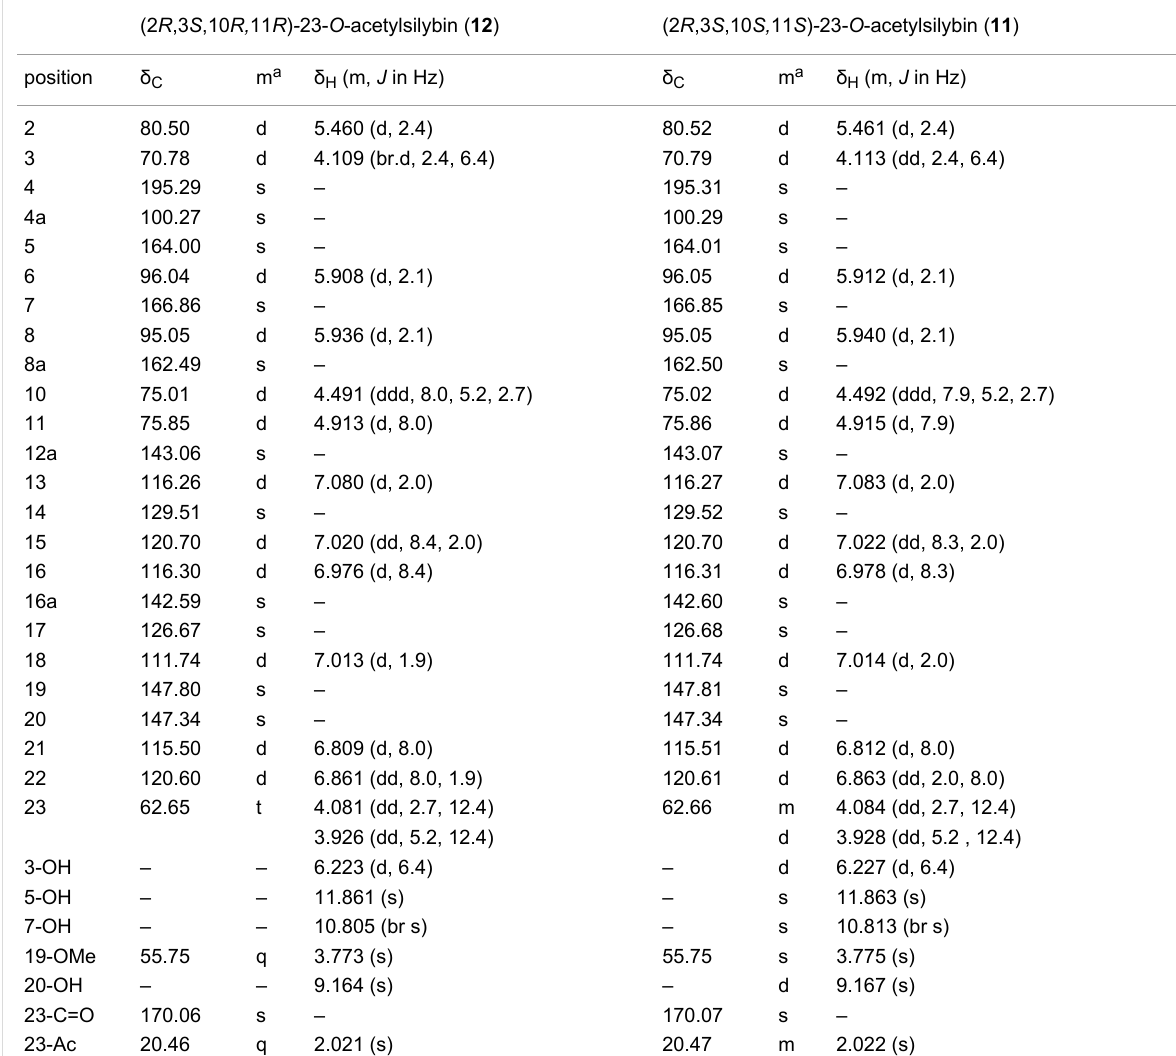
Table 5: NMR spectroscopic data (600 MHz, DMSO- d 6 , 30 °C) of compounds 12 and 11 . (2 R ,3 S ,10 R, 11 R ) - 23- O -acetylsilybin ( 12 )